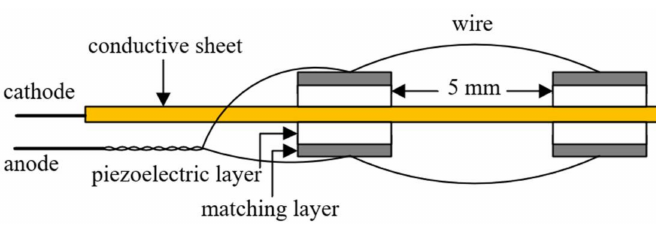
Figure 1. Schematic wiring diagram of the ultrasound core wire.